Question: Provide a publication-style caption for this figure.
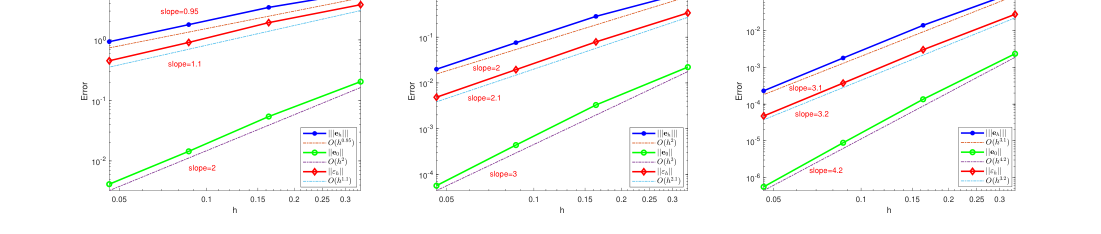
Answer: The numerical results for Example 7.2 on curved triangular meshes with k = 1 (left), 2 (middle), 3 (right).